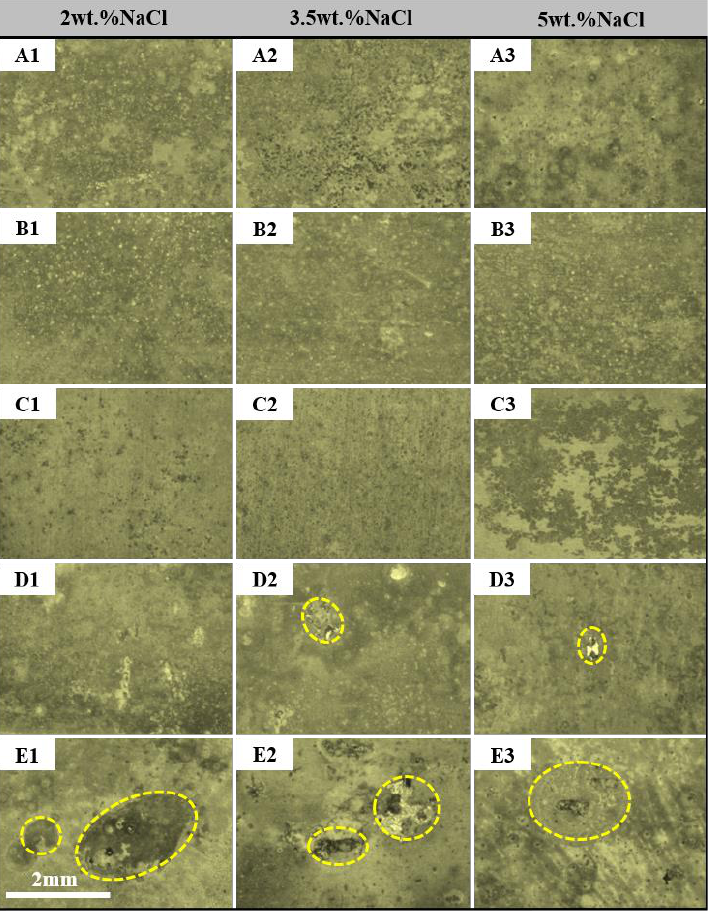
Figure 10. The macroscopic morphology of specimens immersed in different concentrations of NaCl solution for 28 days ( A : 2A97-T3; B : 2A97-T6; C : 2024-T4; D : 2060-T8; E : 2099-T83).